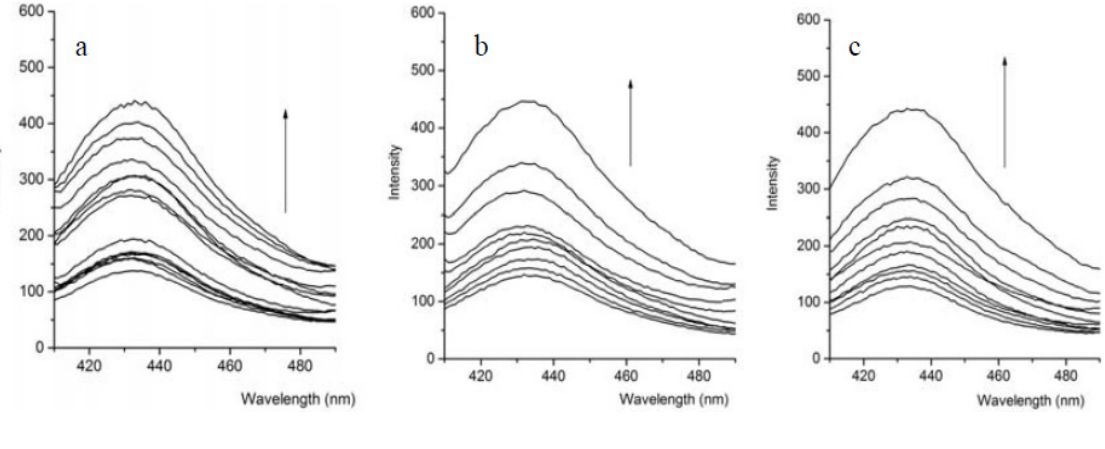
Figure 3. Changes in the emission spectra of compound 1 (4.0 × 10 − 5 mol·L − 1 ) upon the addition of anions (0–80 × 10 − 5 mol·L − 1 ), λ Arrows indicate the increased direction of anion additions.